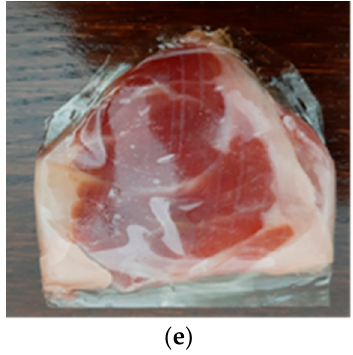
Figure 3. Applications of sodium-alginate-based edible films incorporated with Stevia rebaudiana for ( a ) soluble coffee, ( b ) dehydrated vegetables, ( c ) medicines in powder form, ( d ) cheese slices, and ( e ) meat slices—the pictured packaging film (both welded parts and excedentary parts) are entirely based on sodium alginate agar, and were plasticized with glycerol [35].